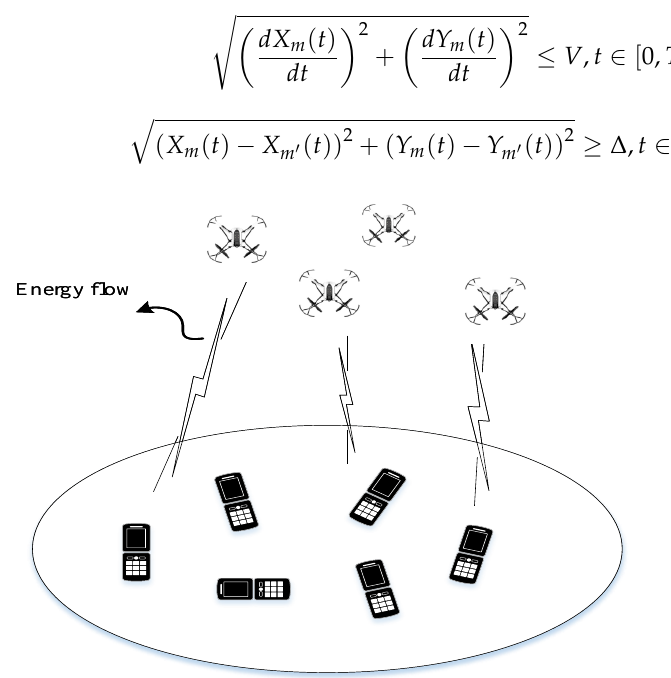
Figure 1. The system model of UAV-aided